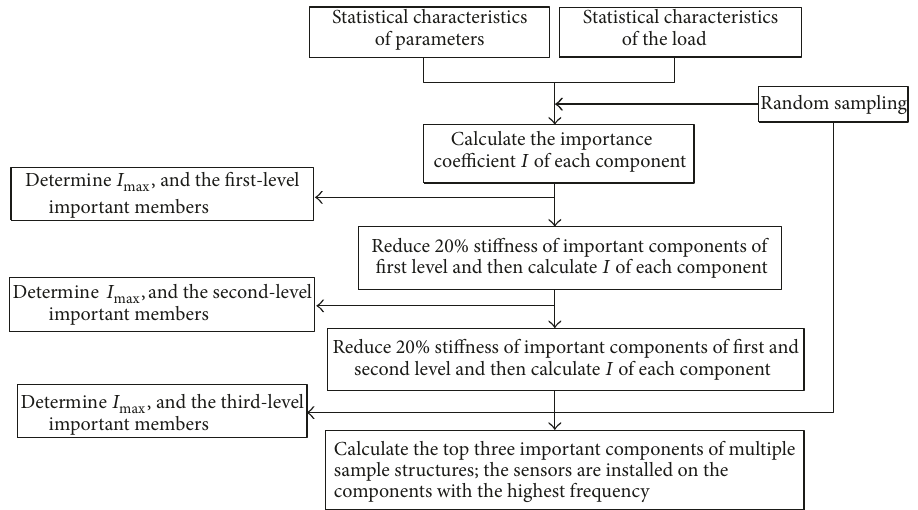
Figure 3: Flow chart of sensor placement considering static